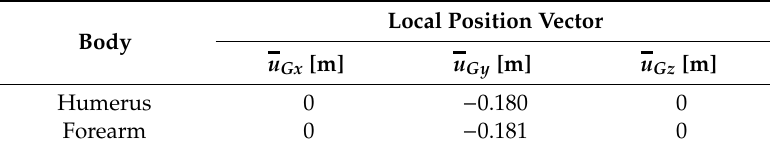
Table 2. Bodies’ mass center position with respect to the reference joints.